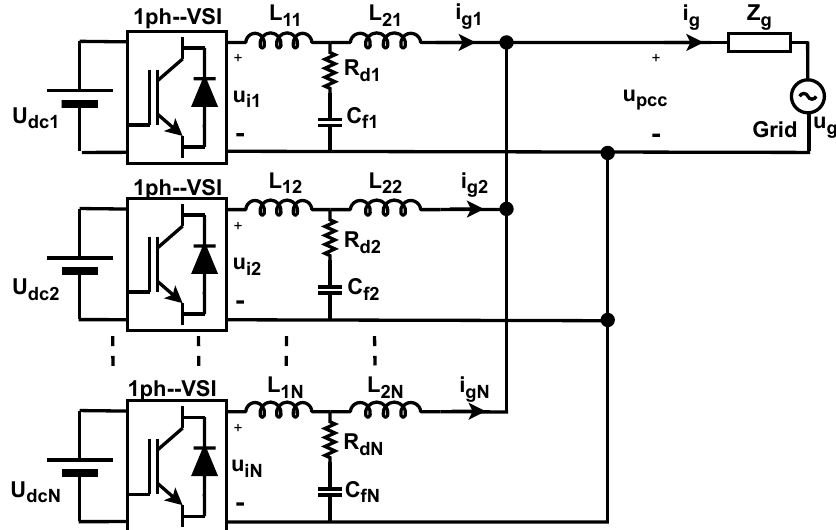
Figure 6. Configuration of multi–paralleled LCL grid–connected inverters